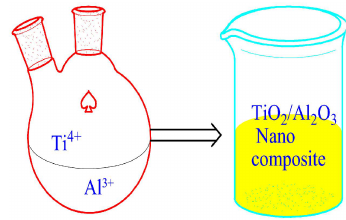
Figure 1. Schematic of nanocomposite